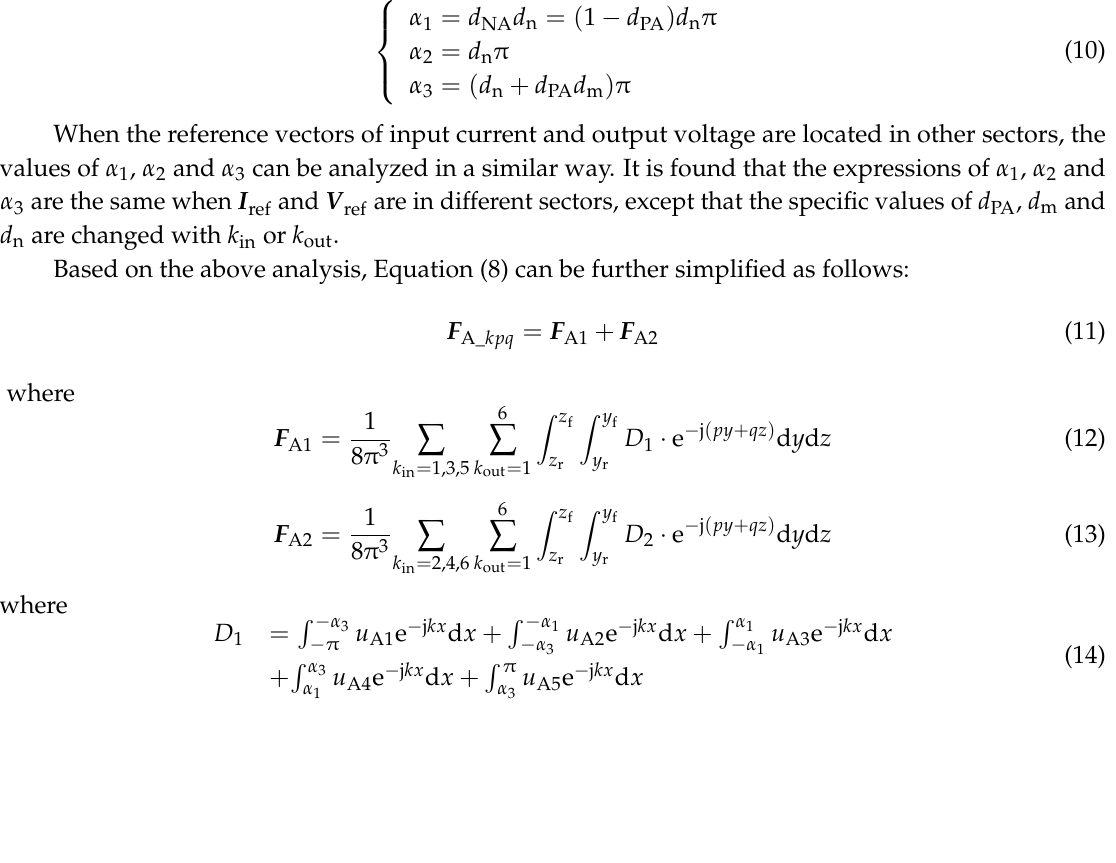
ref and V ref are in the first